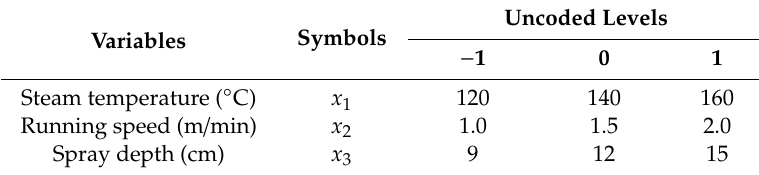
Table 1. Results of the level setting of the target parameters for the Box–Behnken design.